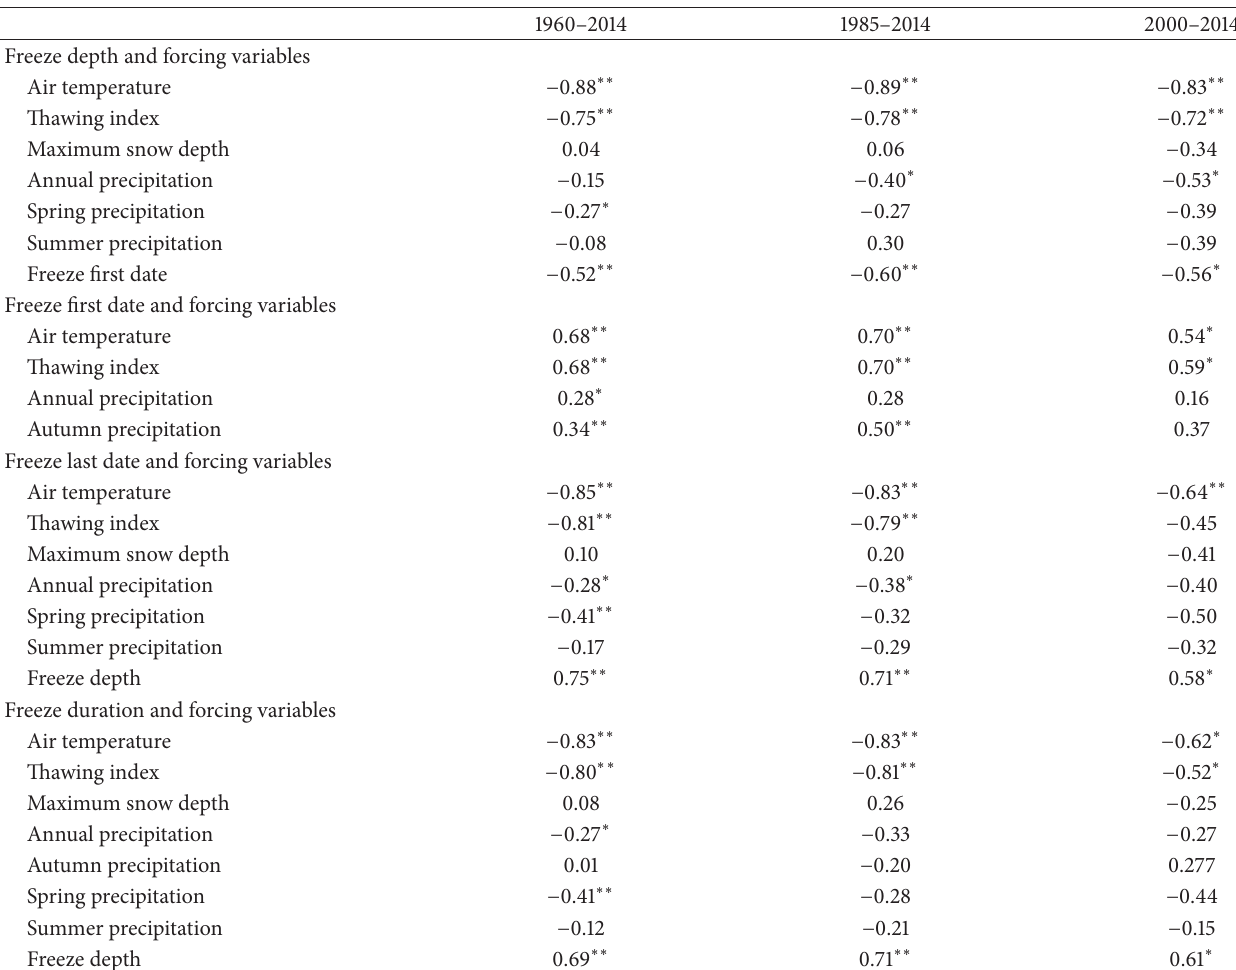
Table 5: Correlation coefficients for freeze depth and forcing variables, freeze first date and forcing variables, freeze last date and forcing variables, and freeze duration and forcing variables for the three different time periods on the TRSR 9 stations (Figure 1). Significance levels: ∗ 𝛼 = 0.05 ; ∗∗ 𝛼 = 0.01